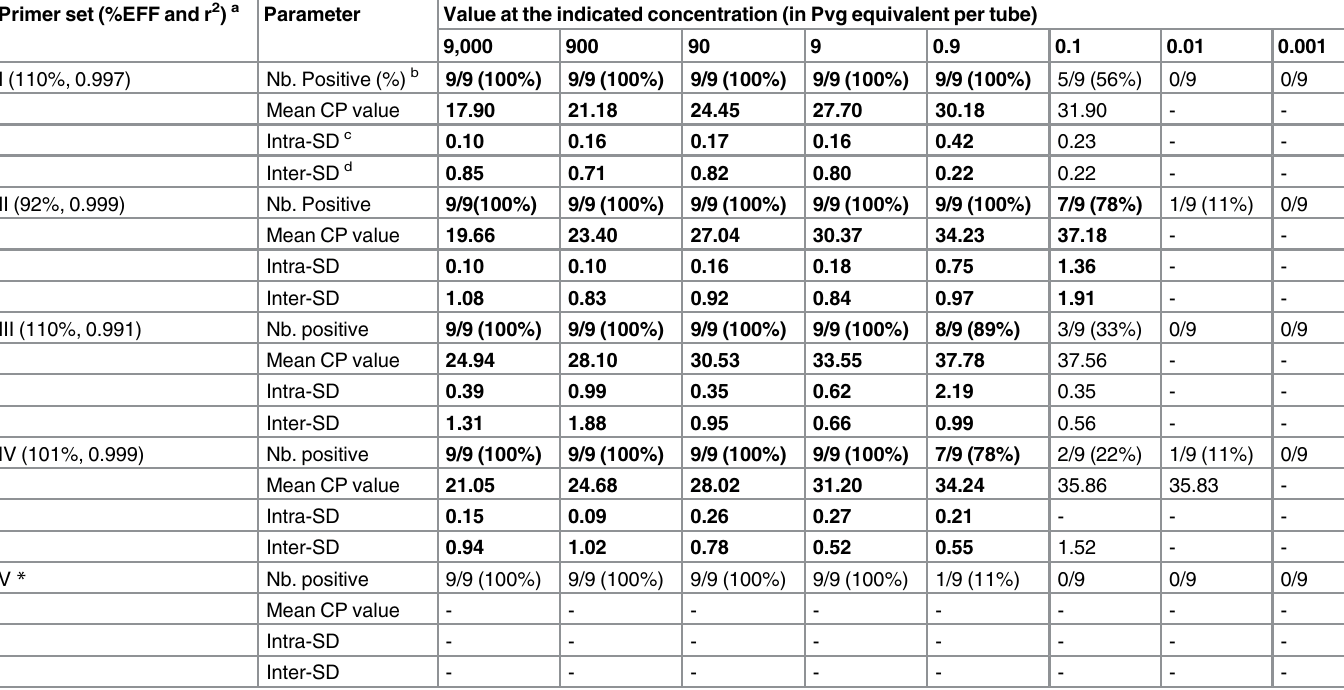
Table 4. Results of the assessment of each primer set on calibrated standards of Plasmodium vivax sporozoites. Primer set (%EFF and r 2 ) a Parameter Value at the indicated concentration (in Pvg equivalent per tube) I (110%, 0.997)